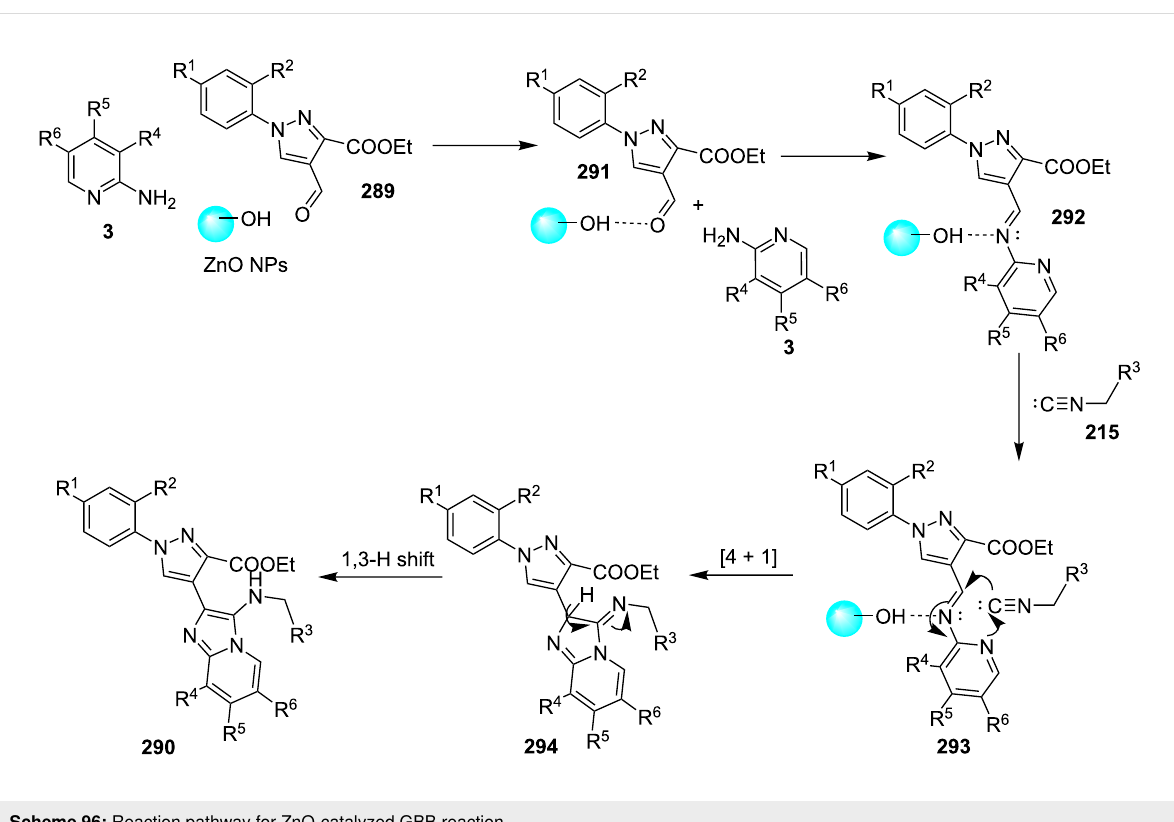
Scheme 96: Reaction pathway for ZnO-catalyzed GBB